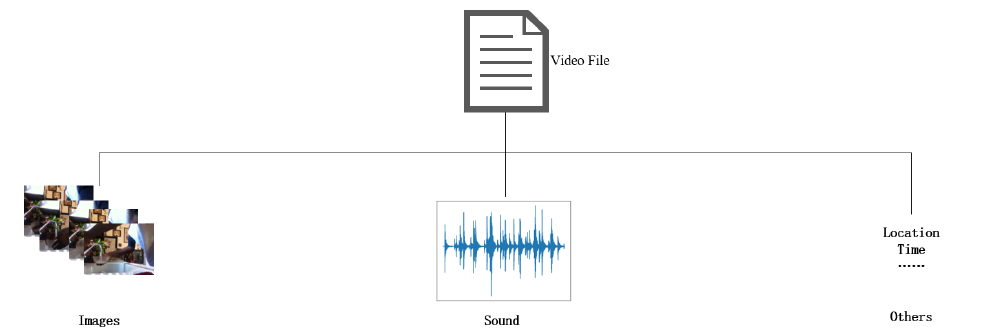
Figure 1. The multimode data in the video